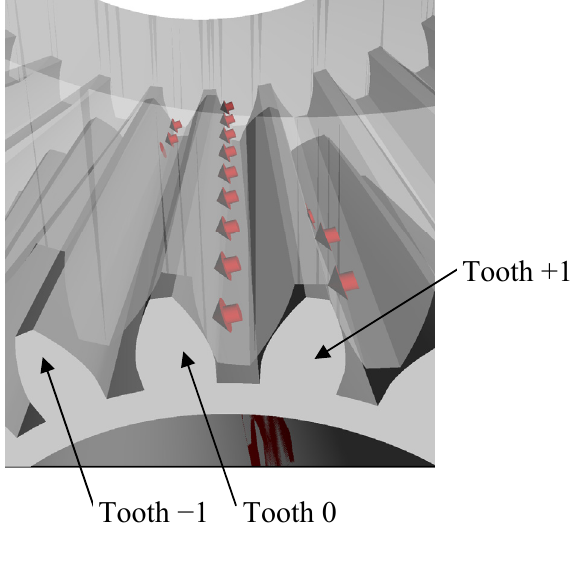
Figure 8. Scheme of meshing